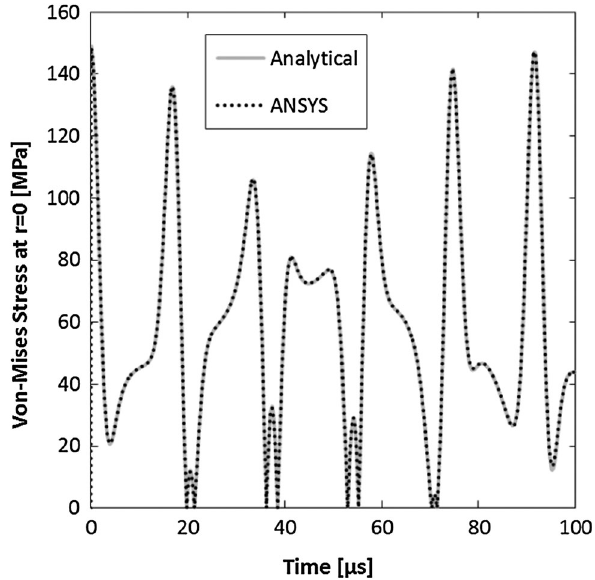
FIG. 7. Von-Mises stress at r ¼ 0 for the test case assuming plane